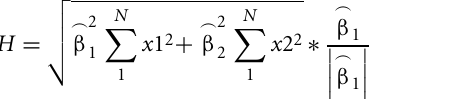
stands for Percentage Signal Change computed using the parameters from the hrf and a scaling factor taken as the maximum of the super-sampled design matrix. PSC corrected stands for Percentage Signal Change computed using the parameters from the hrf and a scaling factor taken as the maximum of a reference trial in the super-sampled design